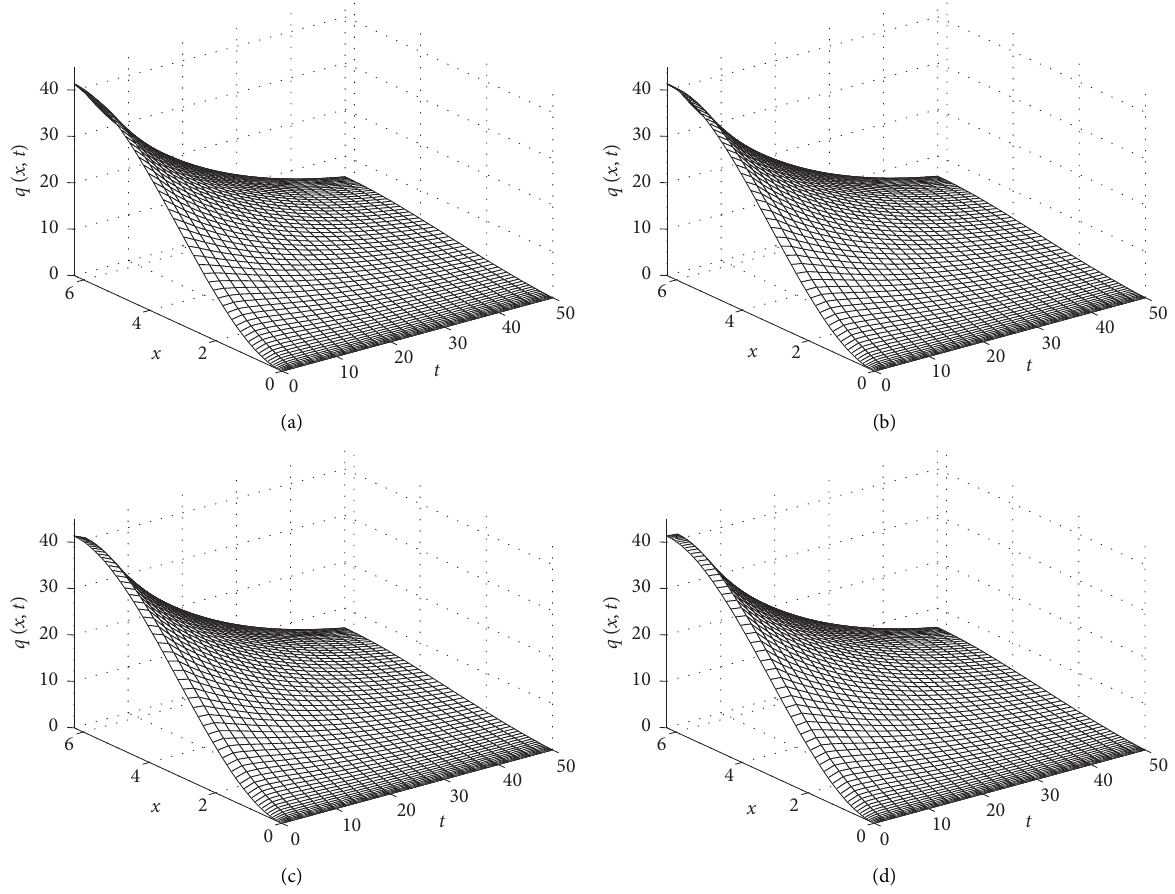
Figure 4: Time evolution of q ( x, t ) in (14) when b ( x ) � x / π − 1, q ( x, s ) � ( 1 + s )( π x 2 − x 3 /3 ) , α � 0 . 4 , β � 0 . 1 , κ � 0 . 02, and for different values of τ : (a) τ � 0 . 02; (b) τ � 0 . 04; (c) τ � 0 . 06; (d) τ � 0 . 1.